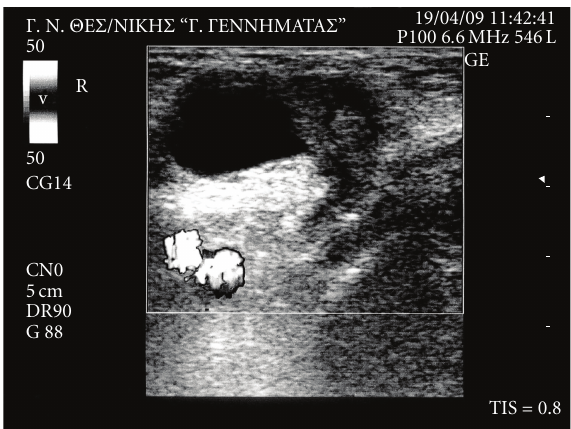
Figure 1: Ultrasonography showing the oedematous hernia sac, above the femoral vessels.